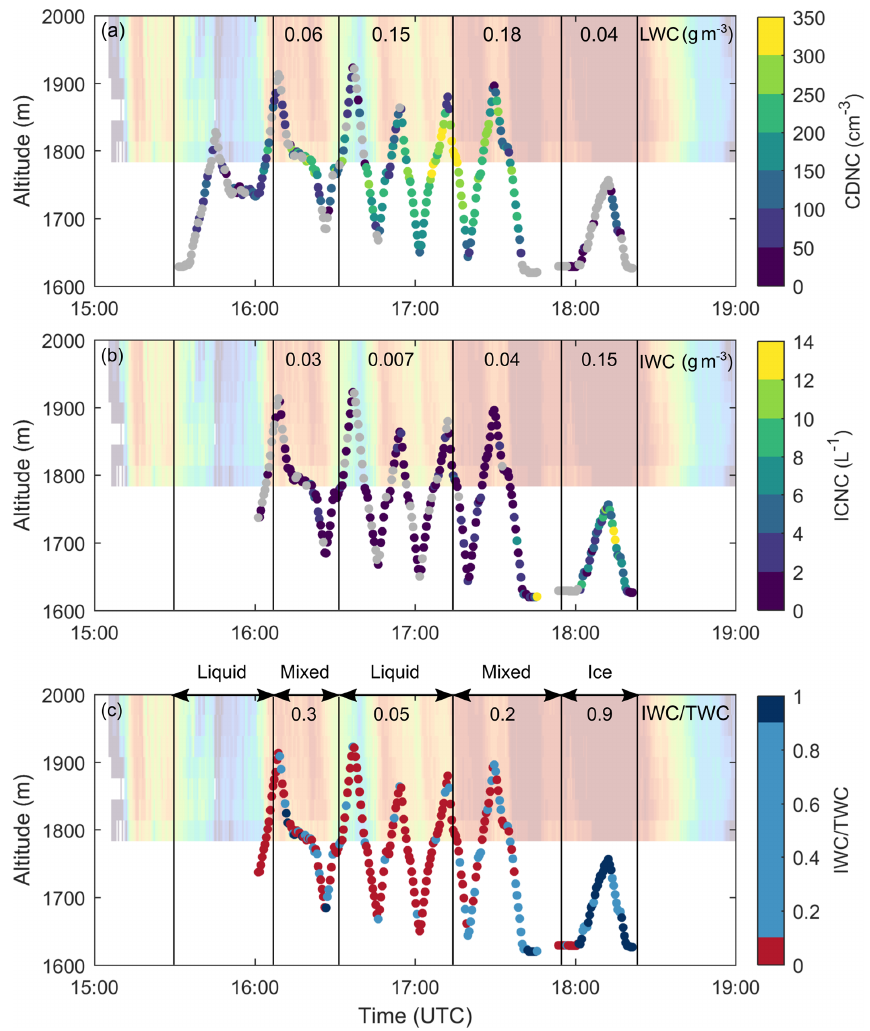
Figure 6. Vertical in situ profiles of the CDNC (a) , ICNC (b) and the IWC / TWC ratio (c) . The gray dots in (a) and (b) indicate measurement points which are associated with a liquid water content (LWC) of < 0 . 01gm − 3 (for CDNC) or an IWC of 0L − 1 (for ICNC). In (c) , red colors represent liquid cloud regions (IWC / TWC < 0.1), light blue mixed-phase cloud regions (0.1 ≤ IWC / TWC < 0.9) and dark blue ice cloud regions (IWC / TWC ≥ 0.9). The cloud radar reflectivity is shown in the background. The numbers in (a) , (b) and (c) indicate the mean LWC, IWC and IWC / TWC ratio within the intervals defined by the black vertical